Question: Write the caption for this figure.
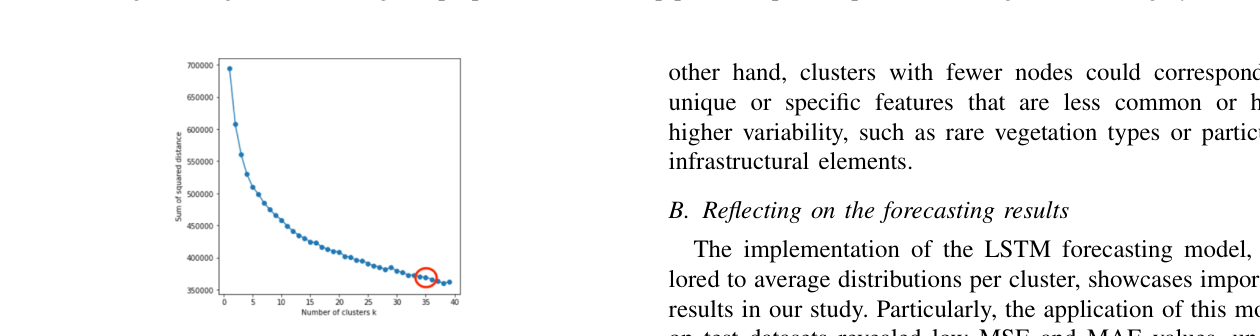
Answer: Elbow method visualization for determining the optimal number of clusters in K-means clustering. The curve shows a distinct bend at the point circled in red, indicating that 35 clusters result in a reasonable trade-off between within-cluster variance and the number of clusters.